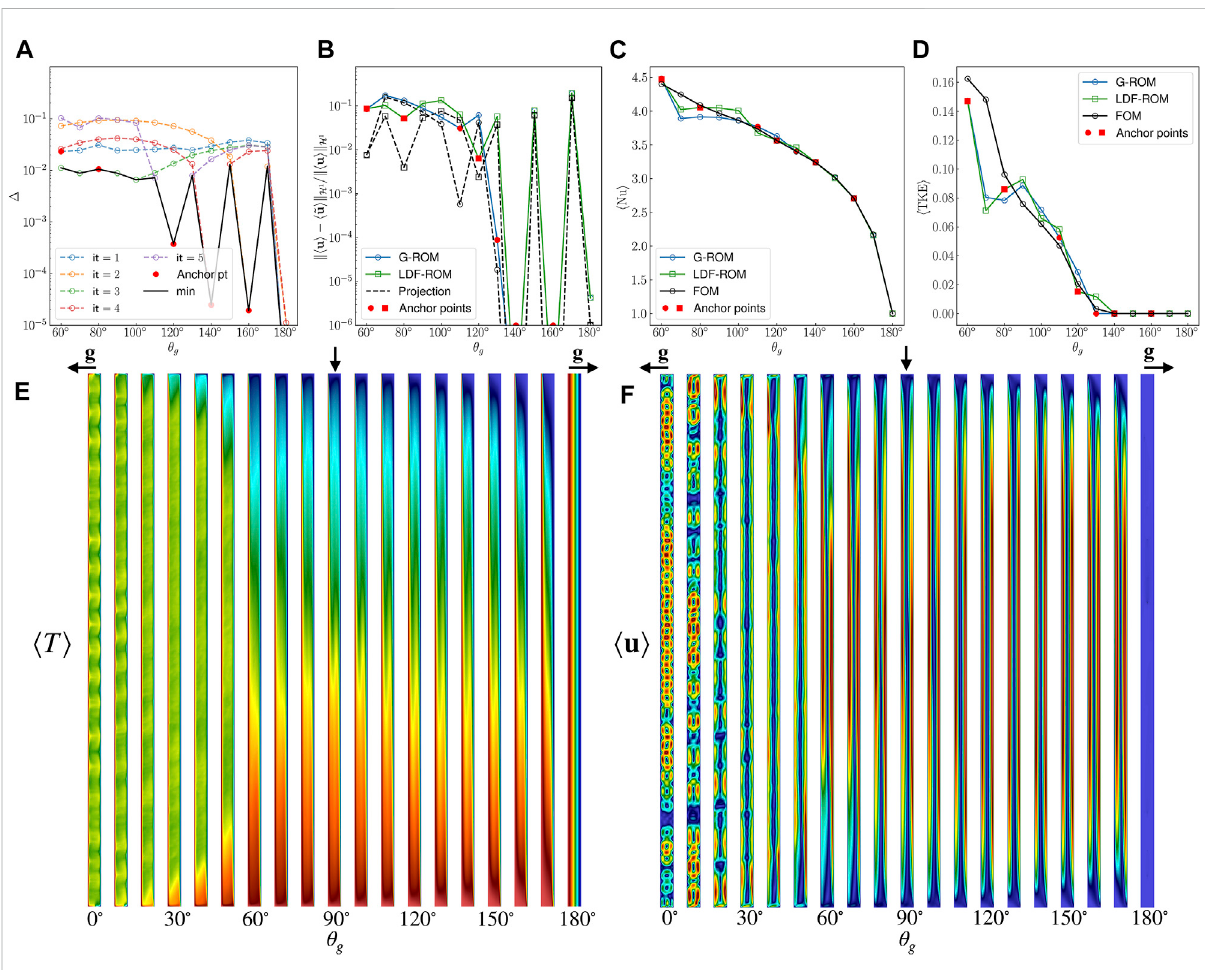
FIGURE 5 POD- h GreedyperformancecomparisonbetweenG-ROMandLDFROMfortheparametric problemparameterizedwith θ g ∈ [60 ° ,180 ° ]atRa= 3 × 10 5 and Pr = 7.2. (A) Behavior of the error indicator Δ de fi ned in Eq. 44 for fi ve iterations with LDF-ROM. (B – D) Behavior of the relative H 1 error in predictedsolution,meanNuandmeanTKEwith